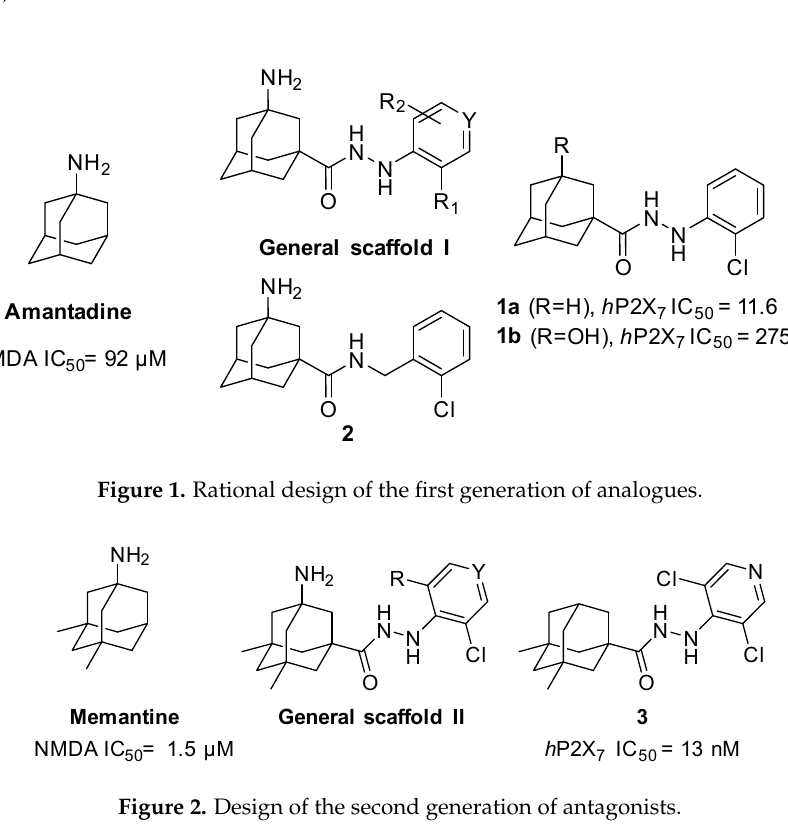
Figure 2. Design of the second generation of antagonists.